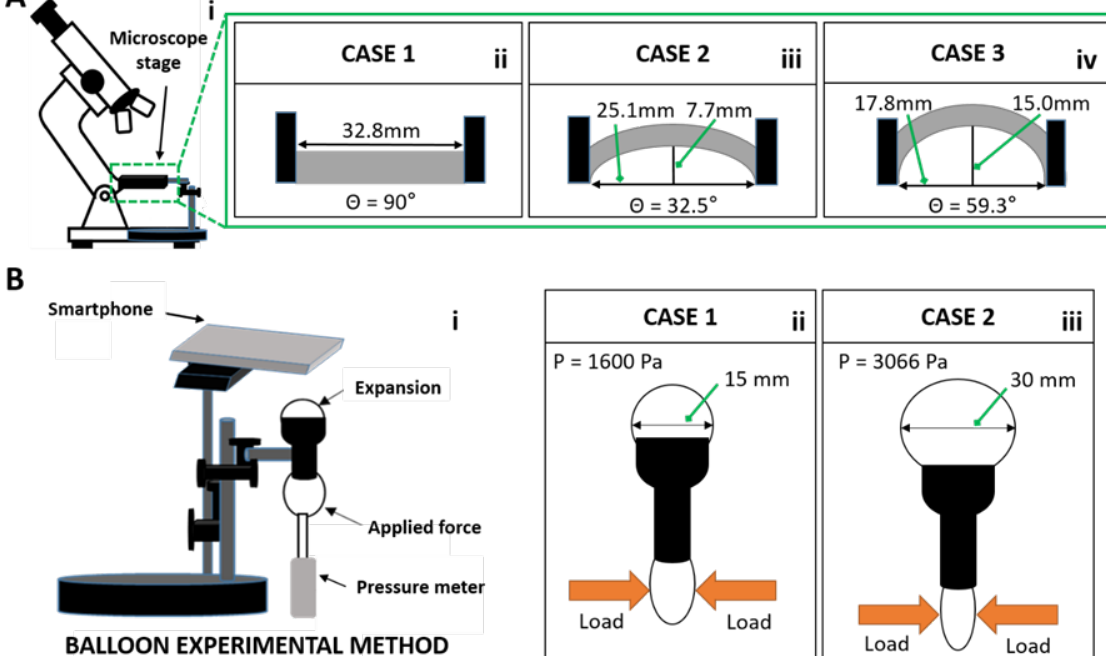
Figure 2. Experimental setup to apply different curvatures to the contact lens and record the corre- sponding variations in the ring interspace. ( A ) Microscope stages: flat, curved at 7.7 mm, curved at 15 mm; ( B ) the balloon method: illustration for effect of the internal pressure on the surface curvature of the balloon.